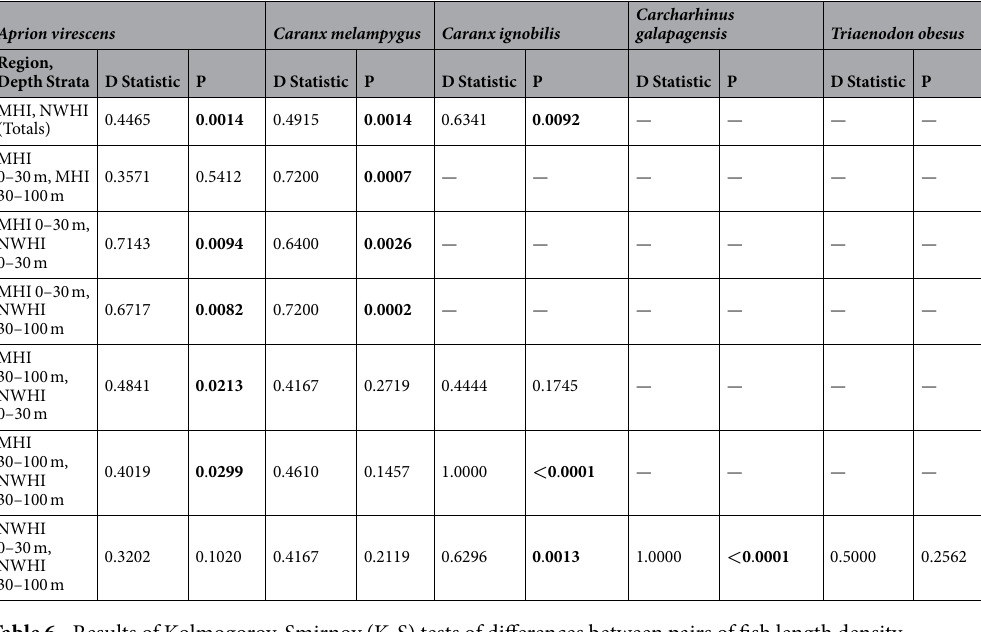
Table 6. Results of Kolmogorov-Smirnov (K-S) tests of differences between pairs of fish length density distributions sampled by region and depth strata. Bonferroni corrections were applied to for multiple depth comparisons ( Aprion virescens and Caranx melampygus , α = 0.0083; Caranx ignobilis , α = 0.017). Values in bold are significant at < 0.05.